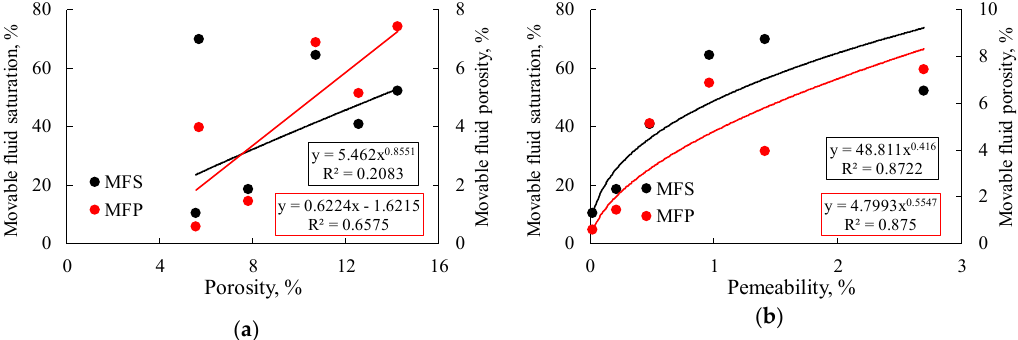
Figure 15. The plot of movable fluid parameters versus ( a ) porosity and ( b ) permeability. MFS-movable fluid saturation; MFP-movable fluid porosity.